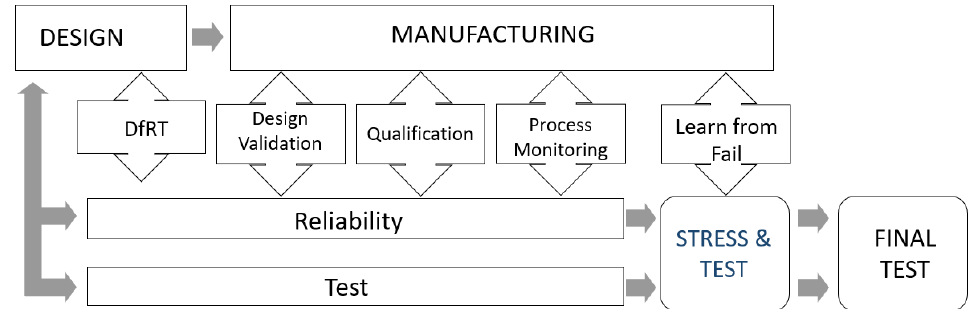
Figure 4. How Test for Reliability affects the flow.